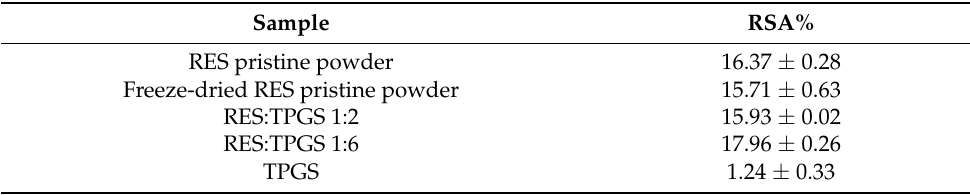
Table 3. In vitro antioxidant activity of RES (raw powder, lyophilized raw powder), RES:TPGS formulations, and TPGS alone, calculated as percentages of radical scavenging activity (RSA%). Results are expressed as mean ±